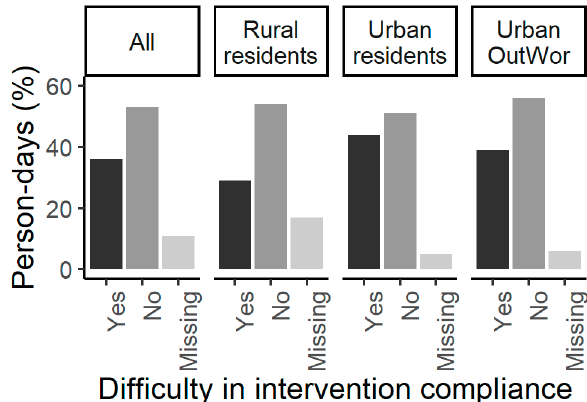
Figure 2. Person-days with self-reported compliance difficulty. Missing = participant did not report if she had difficulty in complying the intervention on a person-day. Pearson’s Chi-squared test showed that there was significant difference in the binary outcome of reported difficulty between Rural residents and Urban residents (Chi-Square = 8.83, Degrees of Freedom = 1, p -value = 0.003), and no significant difference between Urban residents and Urban OutWor (Chi-Square = 1.12, Degrees of Freedom = 1, p -value = 0.29).